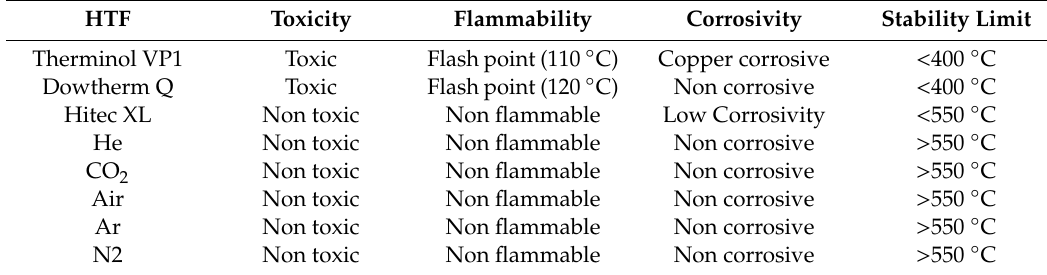
Table 2. Comparison between Heat Transfer Fluid